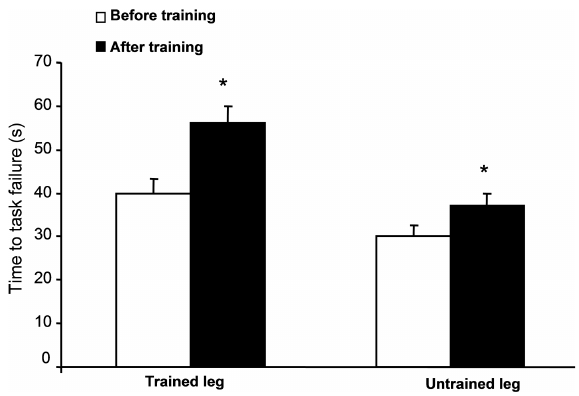
Figure 2. Time to task failure in the trained and un- trained leg (mean ± SE , N = 15) during sustained iso- metric knee extension at 50% of the maximal voluntary contraction measured before and after 12 weeks resis- tance training. * p ≤